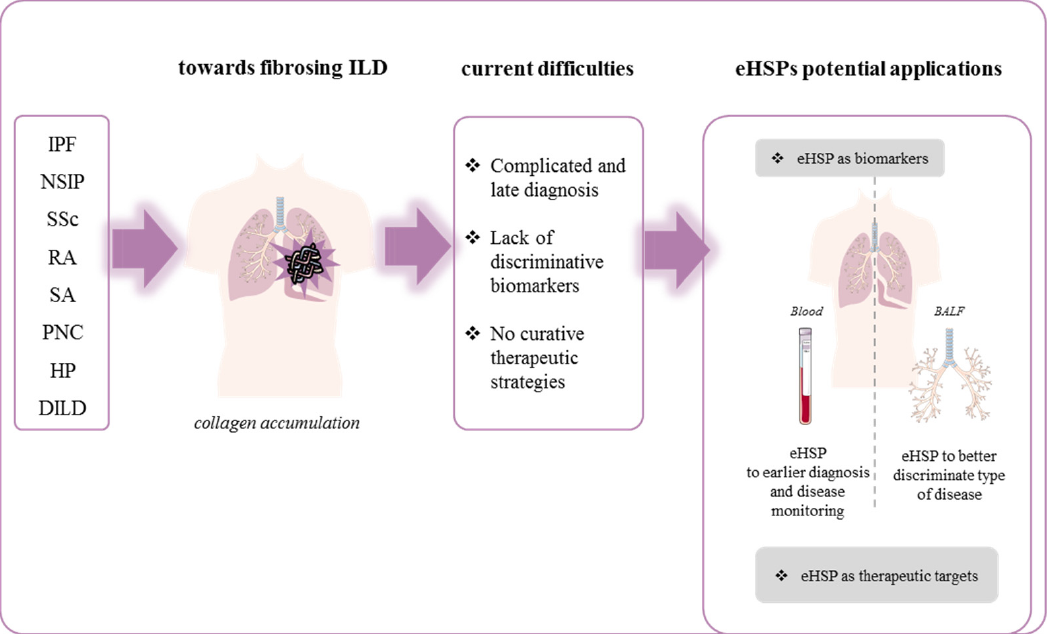
Figure 2. eHSPs are a promising biomarker and therapeutic target in ILDs. IPF: idiopathic pulmonary fibrosis; NSIP: nonspecific interstitial pneumonia; SSc: systemic sclerosis; RA: rheumatoid arthritis; SA: sarcoidosis; PNC: pneumoconiosis; HP: hypersensitivity pneumonitis; DILD: drug-induced lung disease. Table 2. Incorporation of pathogenic roles of eHSP in ILDs that implicate their roles as Auto- biomarkers and as therapeutic molecules. Pathology eHSP Protein